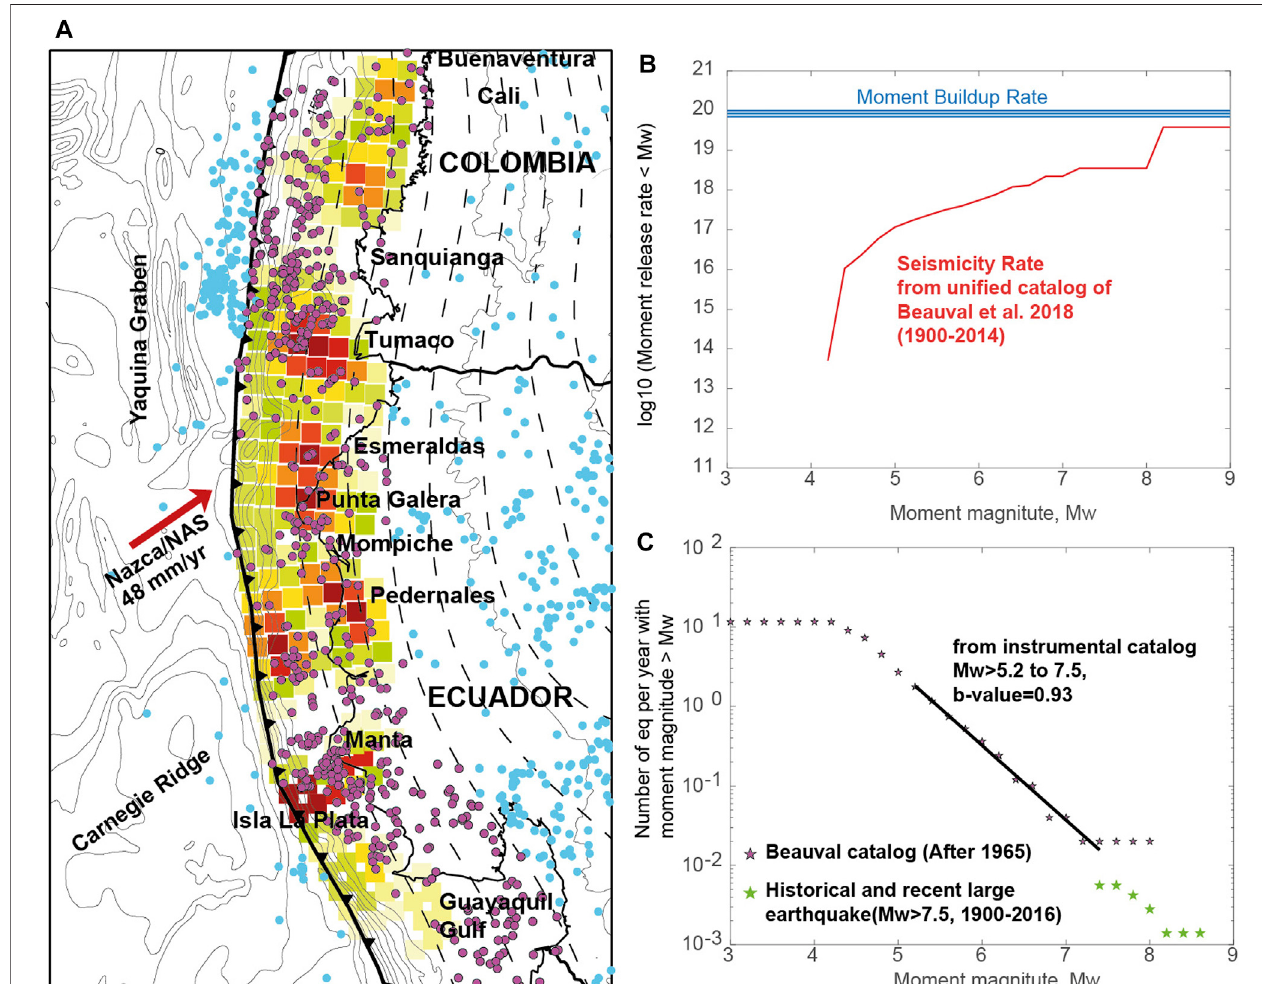
FIGURE 8 | Seismic Catalog in map view, Gutenberg – Richter model of the 1965-2014 instrumental seismicity, and seismicity rate vs. the moment de fi cit rate. (A) Uni fi ed seismic catalog from Beauval et al. (2018) (blue and purple dots) with selected subduction event of the background seismicity (purple dots). (B) Balance of the interseismic moment buildup and the seismic moment released by the subduction earthquakes in the Ecuador – Colombia subduction segment. Blue lines show the moment buildup rates calculated from the coupling models shown in Figure 4 . Red line shows the seismic rate from the uni fi ed seismic catalog (all earthquakes with magnitude less than the abscissa value are added). The seismic rate does not balance the moment buildup rate suggesting that other seismic and aseismic processes are needed to fi ll up the gap. (C) Frequency – magnitude distribution based on the 1965-2014 instrumental seismicity obeys a Gutenberg – Richter law with b values of 0.93 for moment magnitude Mw event in the range 5.2 – 7.5 (black stars). The green stars represent the events with Mw > 7.5.